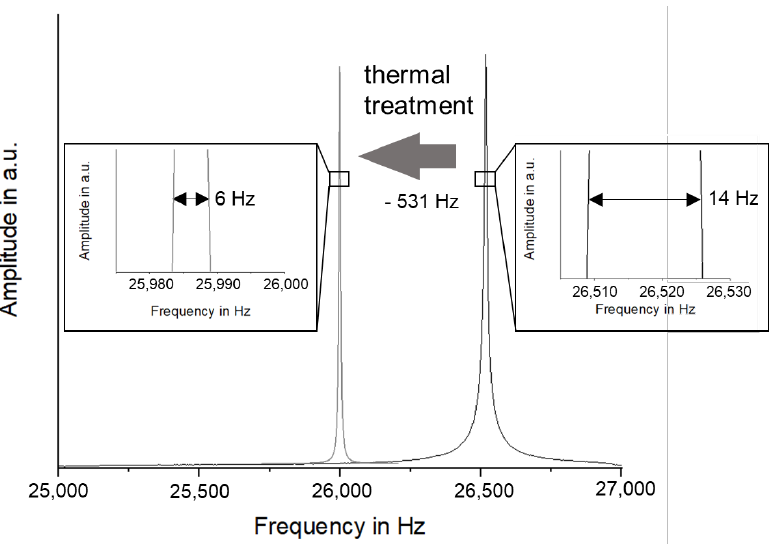
Figure 9. Changes in Eigenfrequency and loss coefficient of Z-M4 PM due to thermal treatment. In the case of lossless oscillation, the wavelength λ of any object depends on the Young’s modulus E , the mass density ρ and the Poisson number as given in Equation (4) for a rod shaped specimen [30].